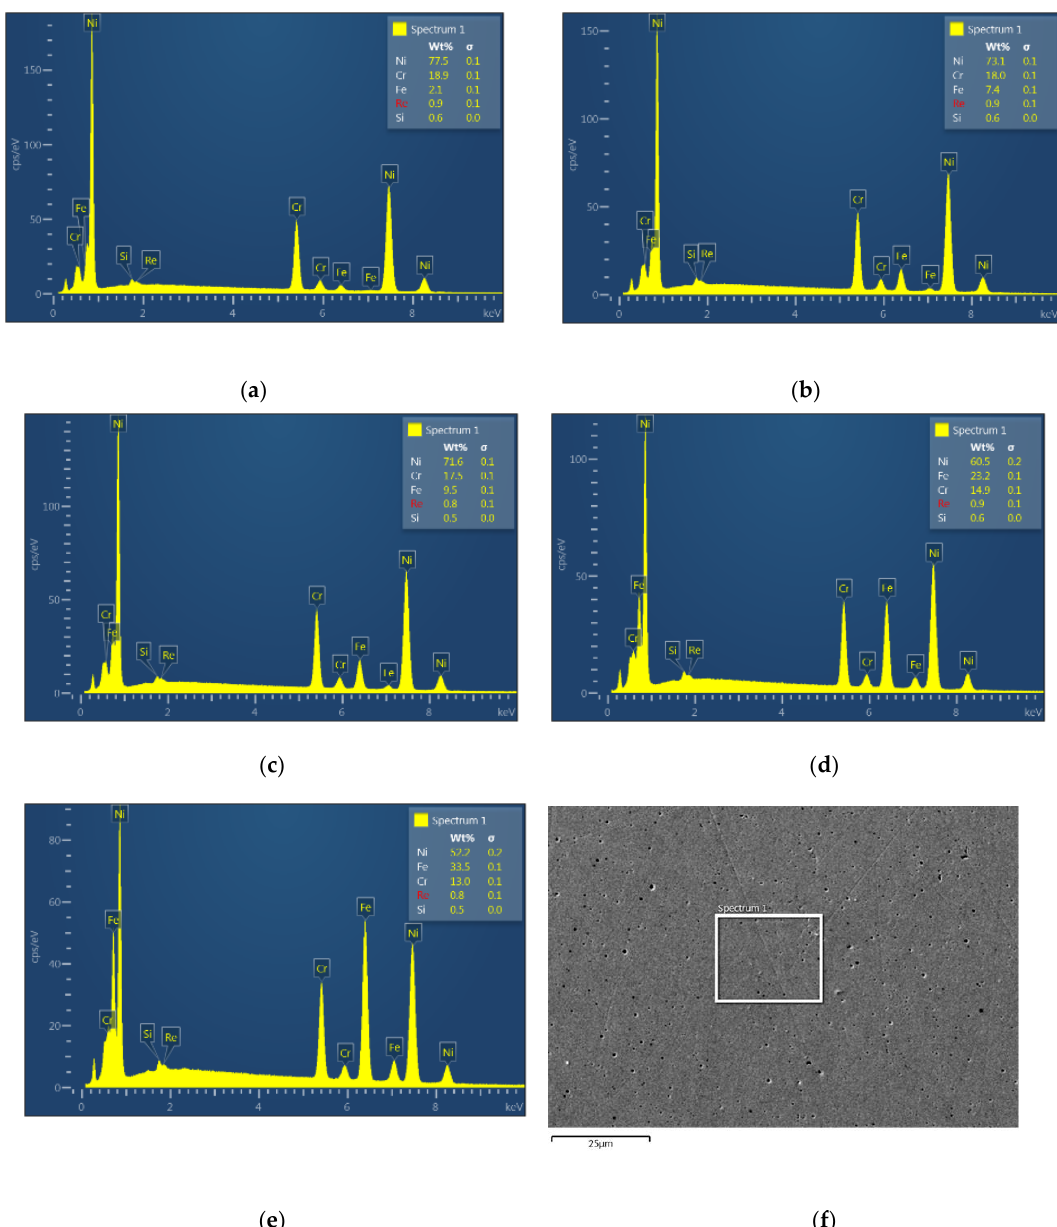
Figure 8. EDS spectrum obtained from the Ni-20Cr+Re clad produced at different laser power: ( a ) 1500 W, ( b ) 1800 W, ( c ) 2100 W, ( d ) 2400 W, ( e ) 2700 W, ( f ) clad area taken for the analysis.